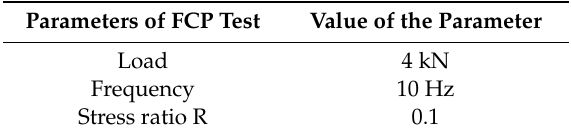
Table 5. Parameters used in fatigue crack propagation (FCP)